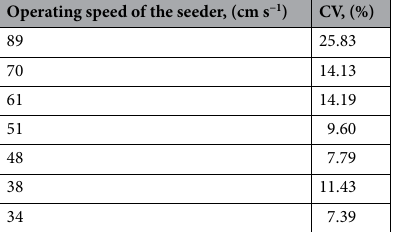
Table 6. Mean values for the coefficient of variation of the spacing between hills of the seeds deposited by the carrot seeder as affected by the levels of operating speed.